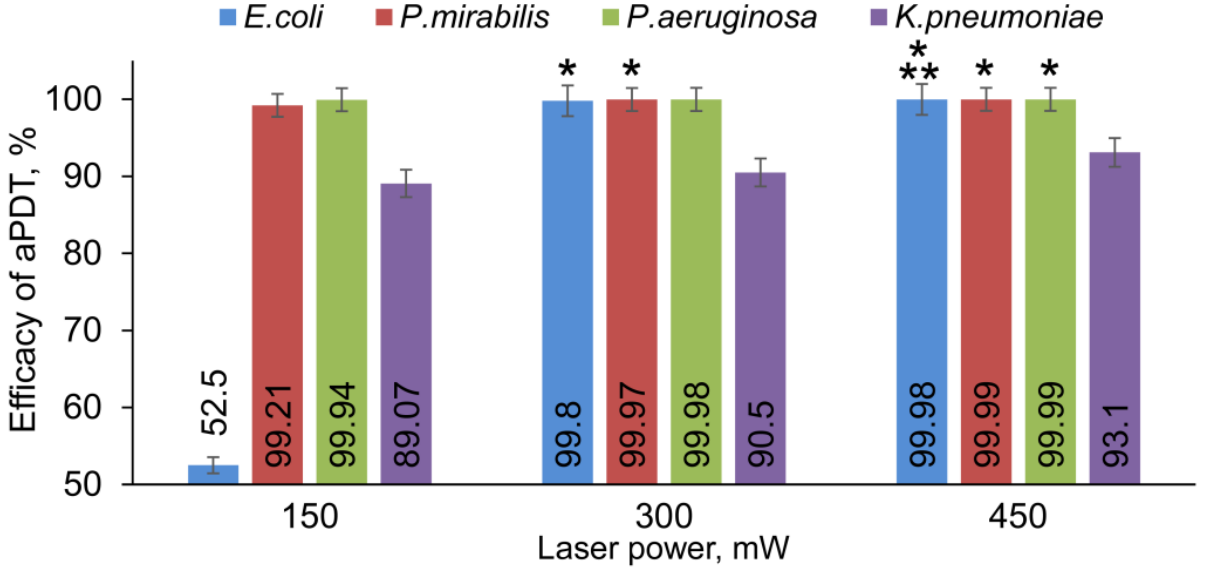
Figure 4. The influence of output laser power on the efficacy of aPDT of Gram-negative bacteria. Bacteria were incubated with Fotoditazin and Triton X-100 for 15 min at room temperature in the dark, and illuminated by continuous wave laser at different output powers. Statistically significant differences compared to the corresponding species irradiated by 150 mW (*) and 300 mW (**) are marked.